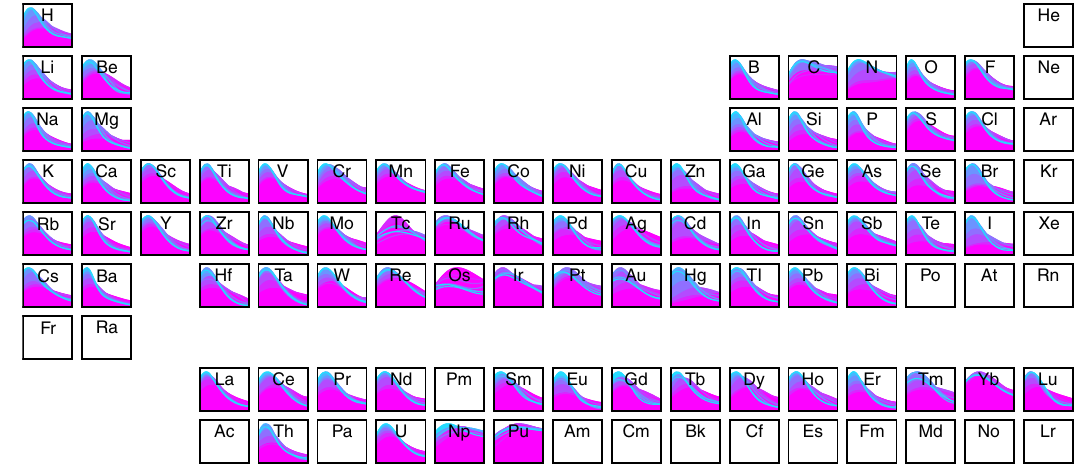
Fig. 6 Composition-dependence of metastability. Elemental partitioning of the results shown in Fig. 5c by compounds containing element X . Each x -axis spans 0 to 100 meV atom − 1 and the colors align with the legend as shown in Fig. 5c